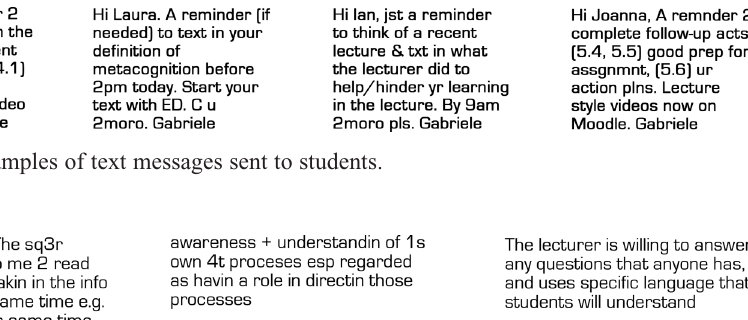
Figure 4. Integrated learning environment. To achieve efficient management and distribution of messages to students, the tutor used a texting management service (Edutxt). The ‘email-like’ web-based user